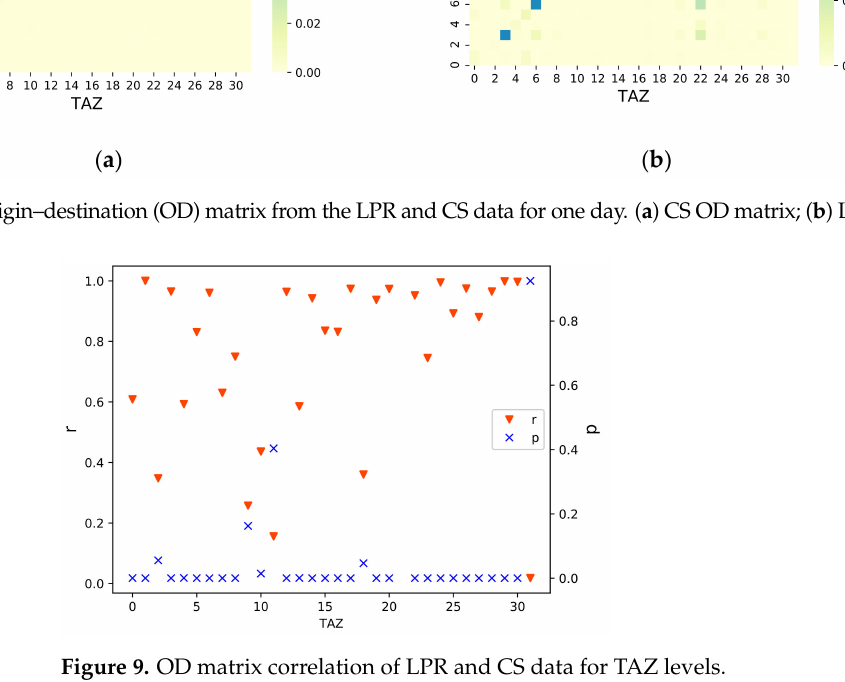
Figure 9. OD matrix correlation of LPR and CS data for TAZ